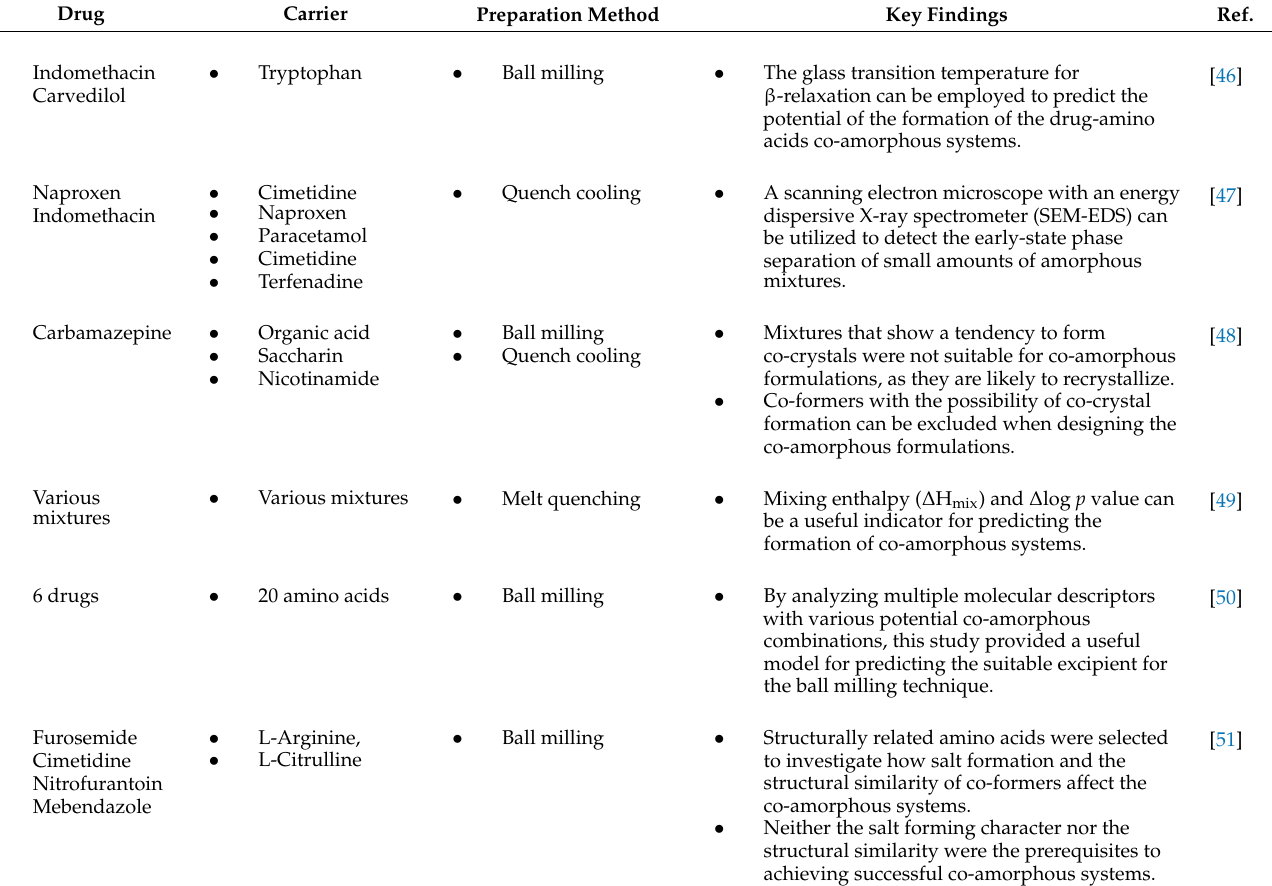
Table 3. Recent publications on the predictive evaluation of co-amorphous